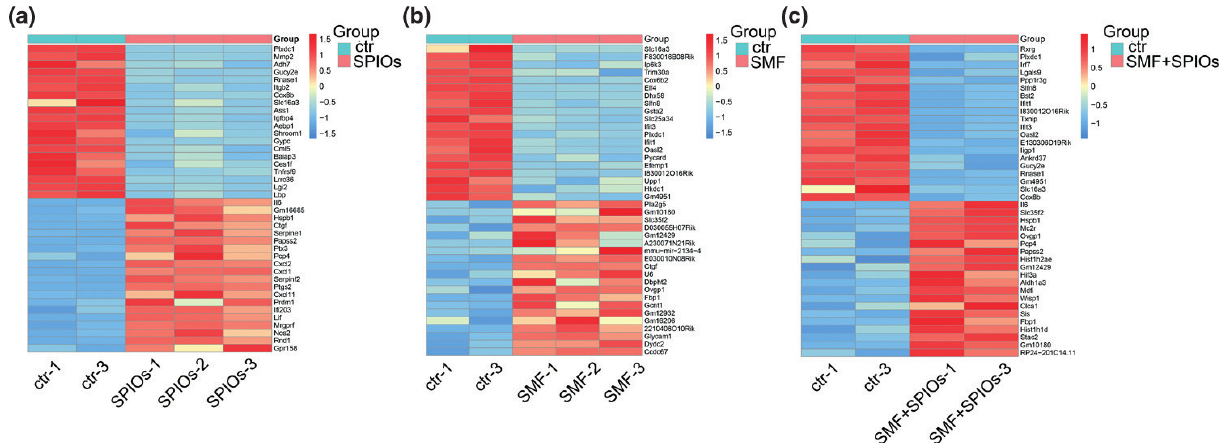
Fig. 2. The heatmap of top 20 significantly high and low expressing genes in different groups. Top 20 significantly upregulated and downregulated expressing genes were shown in SPIOs group (a) (red bar), SMF group (b) (red bar), and SMF + SPIOs (c) (red bar) compared with the control group (green